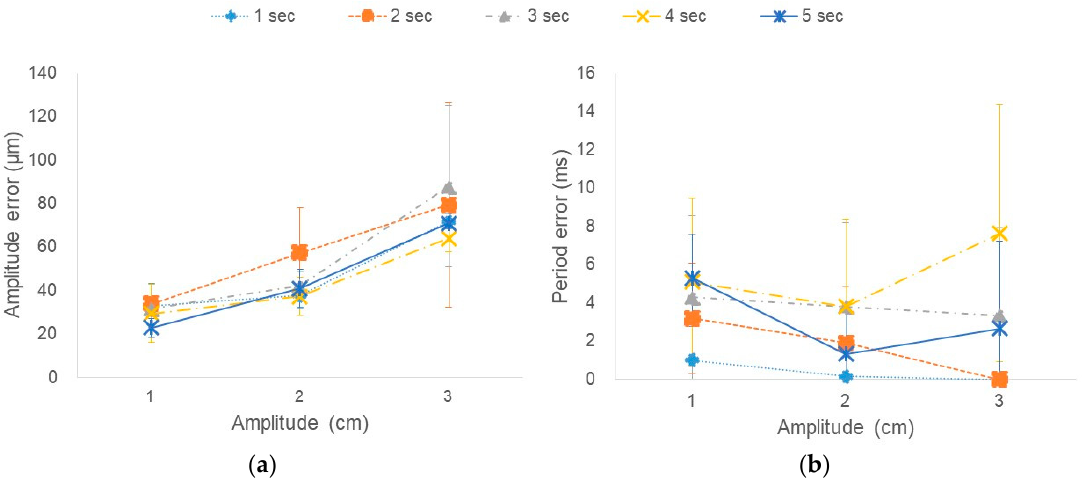
Figure 5. Error in ( a ) amplitude (ms) and ( b ) period ( μ m) by respiration pattern with a period of 1, 2, 3, 4, and 5 s and amplitude of 1, 2, and 3 cm.